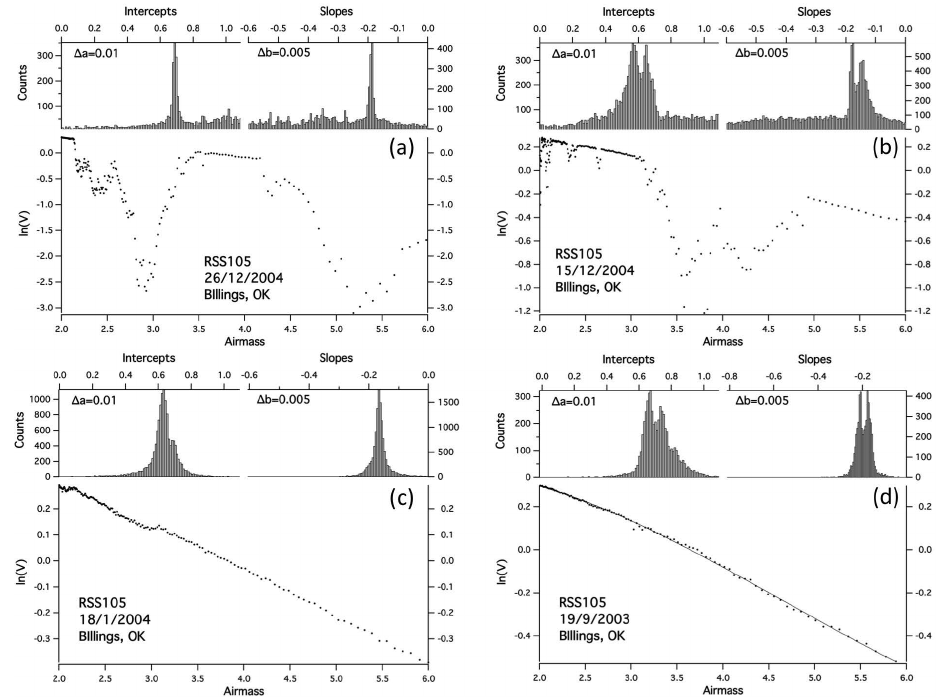
Figure 1. Four cases that illustrate how slope and intercept histograms can aid in analysis of points for the extraction of the Langley plot. In (b) and (d) both the slope and intercept histograms are bimodal. In case (c) only the histogram of intercepts is bimodal. Case (a) has many outliers, but both histograms are mono-modal indicating the existence of a single Langley plot. Case (d) has no large outliers, but y vs. x is nonlinear (third-degree